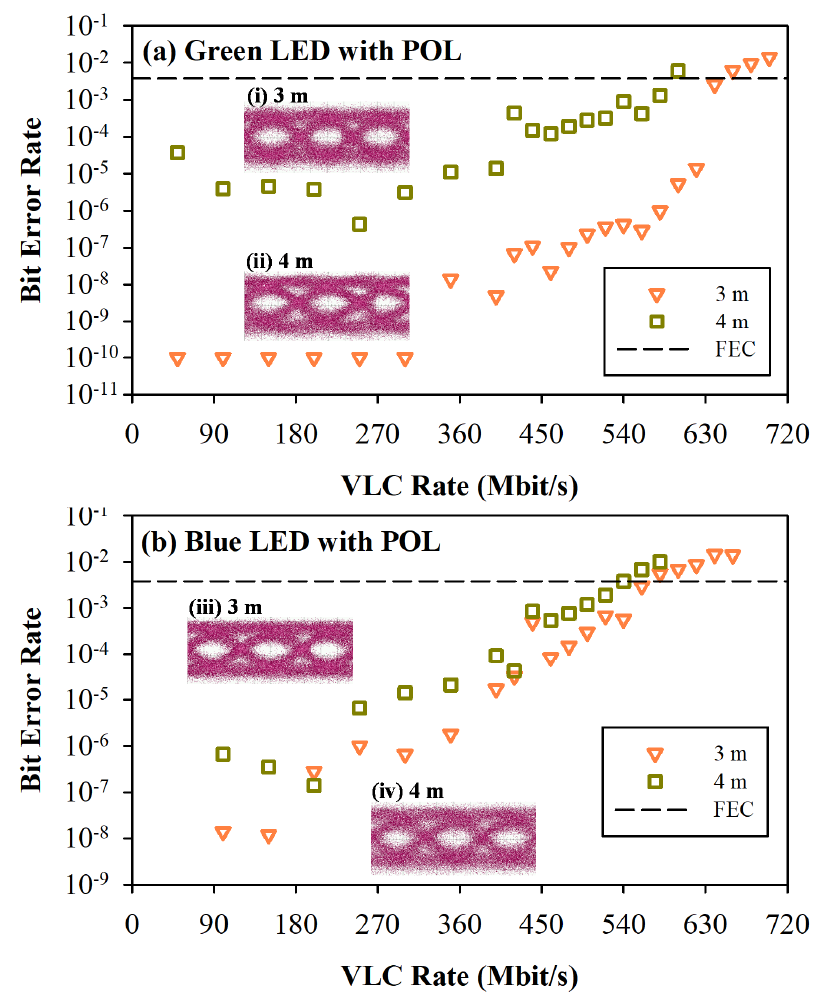
Figure 5. Measured different VLC rates of ( a ) G − and ( b ) B − LEDs versus the corresponding BER after 3 and 4 m free-space transmissions. Insets are the corresponding eye diagrams at the maximum VLC rate below the FEC limit of BER = 3.8 × 10 − 3